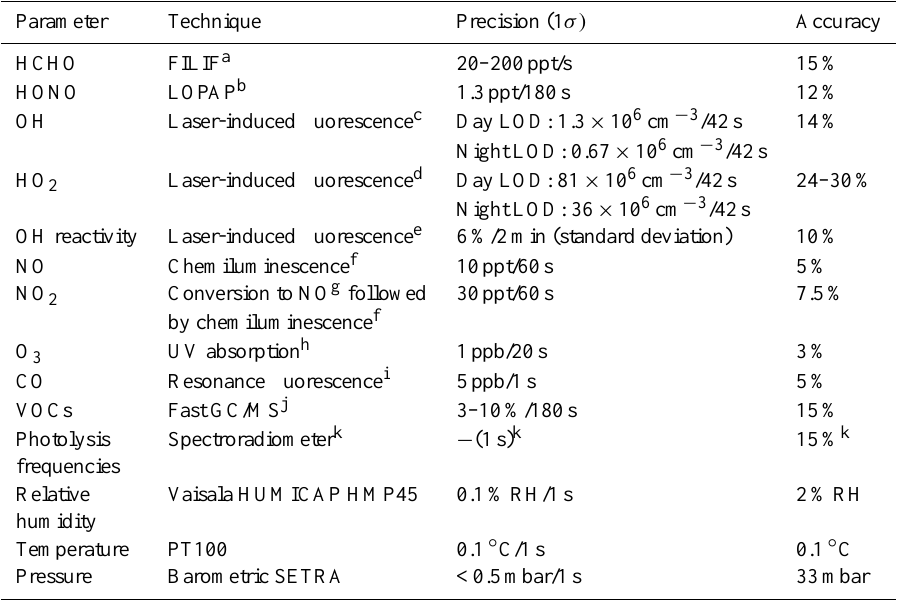
Table 1. Zeppelin-based measurements used for the analysis of O 3 and HCHO production.